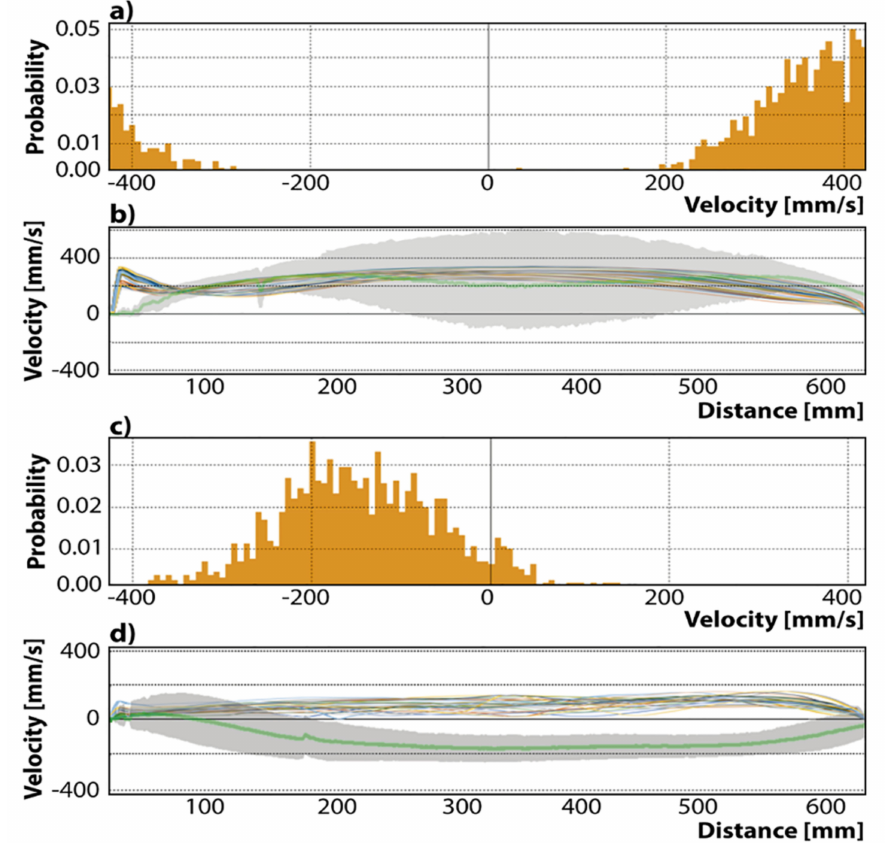
Figure 22. Turbulence features using nozzles with clogging. ( a ) PDF of velocity using nozzle A. ( b ) Velocities calculated by the mathematical model and measured velocity profile using nozzle A. ( c ) PDF of velocity using nozzle B. ( d ) Velocities calculated by the mathematical model and measured velocity profile using nozzle B.